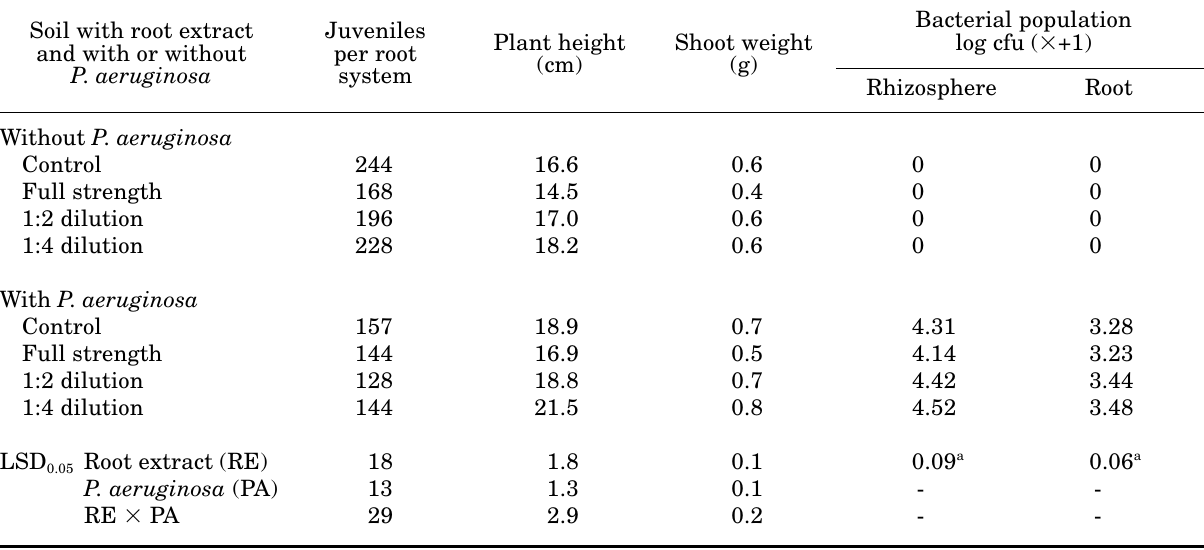
Phytopathologia